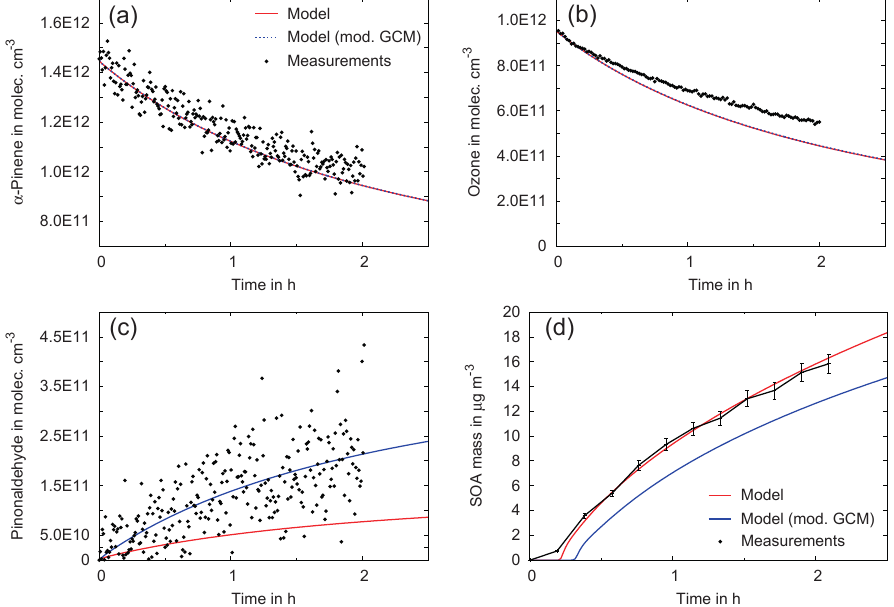
Figure 11. Simulation results for the preferred case of Fig. 8b with k b = 10 − 2 s − 1 (solid red line) and an additional model run with a modified gas-phase chemistry mechanism (GCM, pinonaldehyde yield as provided by Berndt et al. (2003): dashed/solid blue line) in comparison with measurements from LEAK (black dots). Gas-phase concentrations for the reactants (a) α -pinene and (b) ozone are